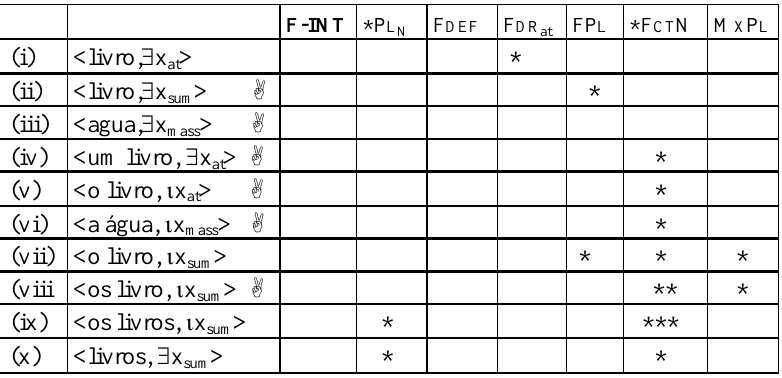
Tableau VI: informal Brazilian